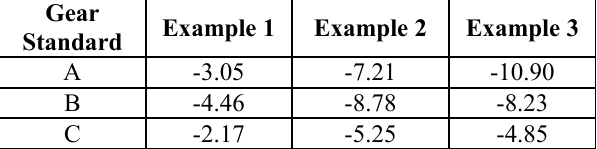
Table 3: Contact Stress Deviations